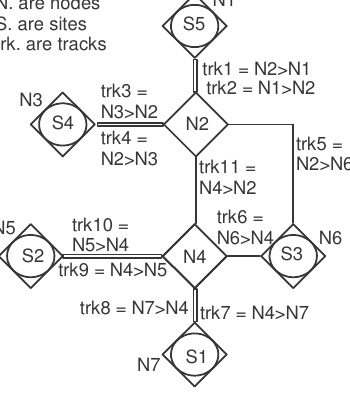
Figure 5. Example of a